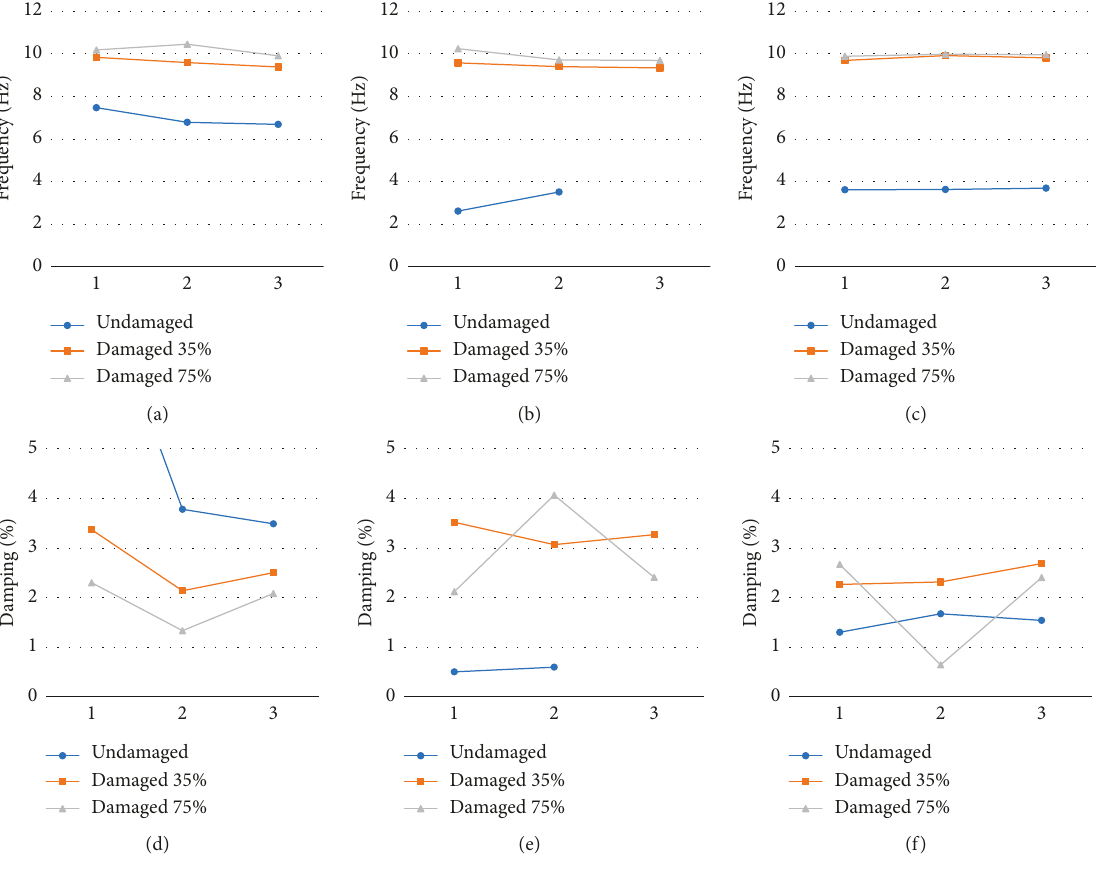
Figure 9: 1st bending modal shape: comparison of dynamic parameters.